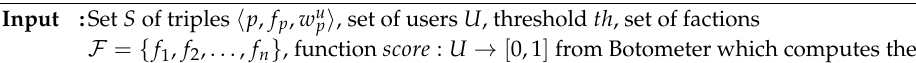
Algorithm 2: User polarization and